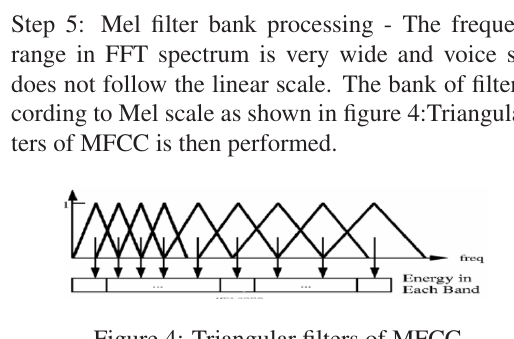
Figure 2: MFCC values in an array Figure 3: Flow Diagram of MFCC Calculation